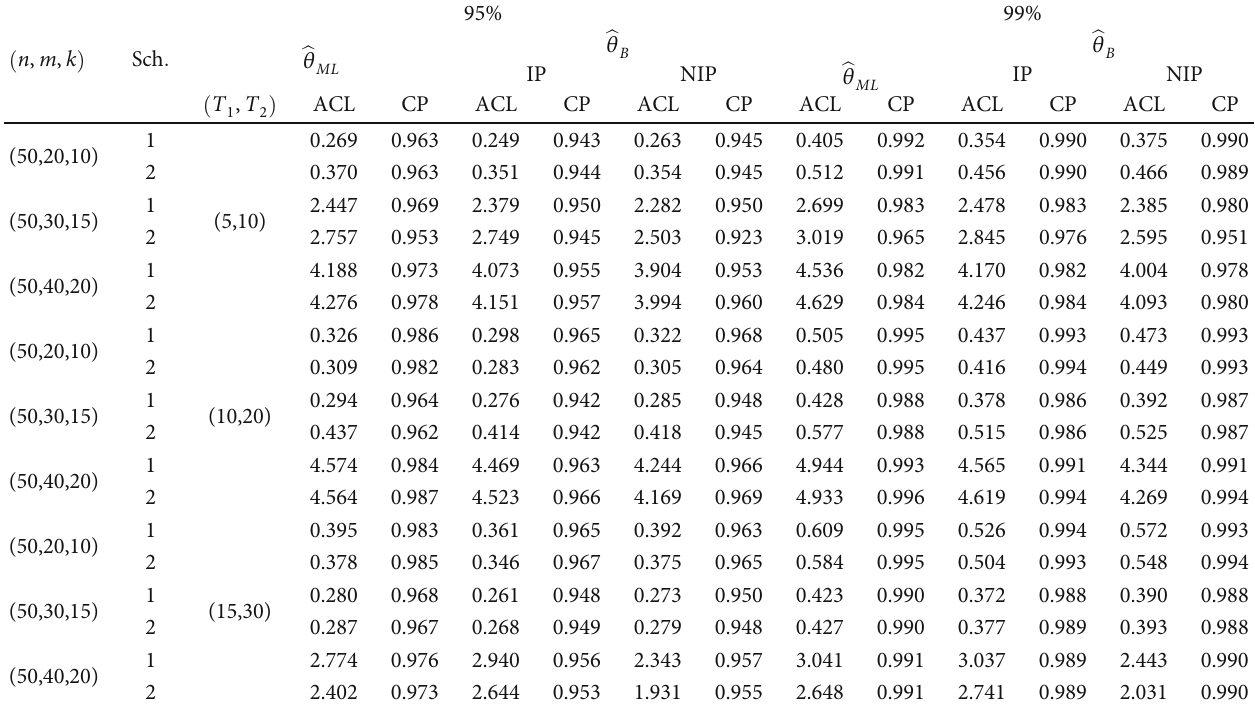
at the di ff erent priors and Type-II uni fi ed